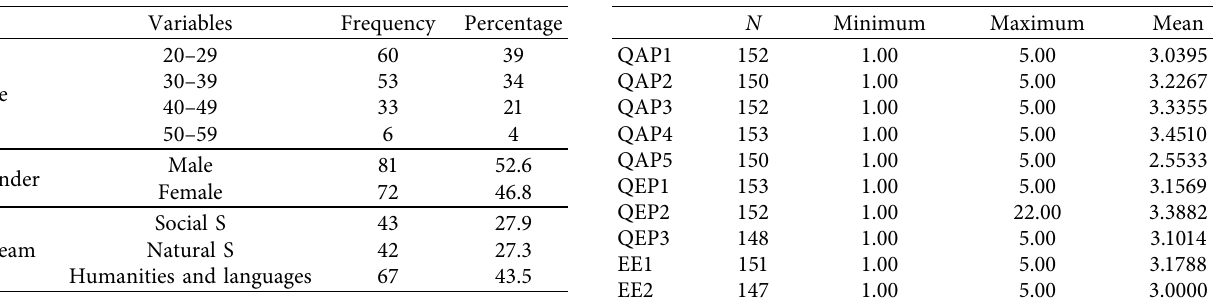
Table 2: Descriptive statistics for constructs.